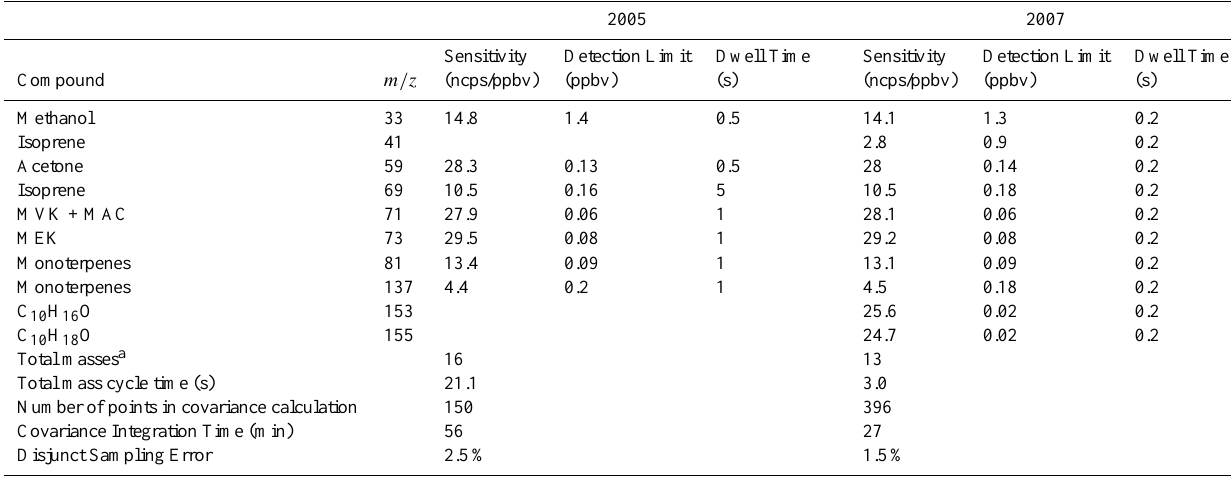
Table 1. Sensitivities, detection limits (1s), dwell times and measurement cycle and covariance calculation parameters for each species and season.